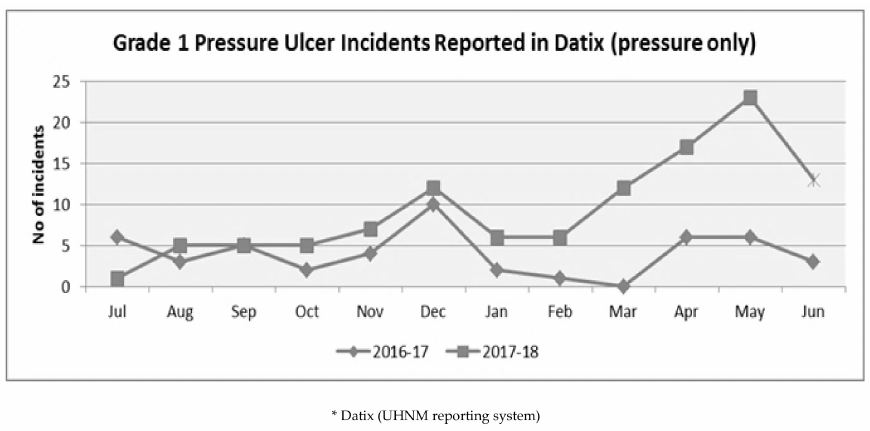
Figure 4. Grade 1 pressure ulcer incidents reported in